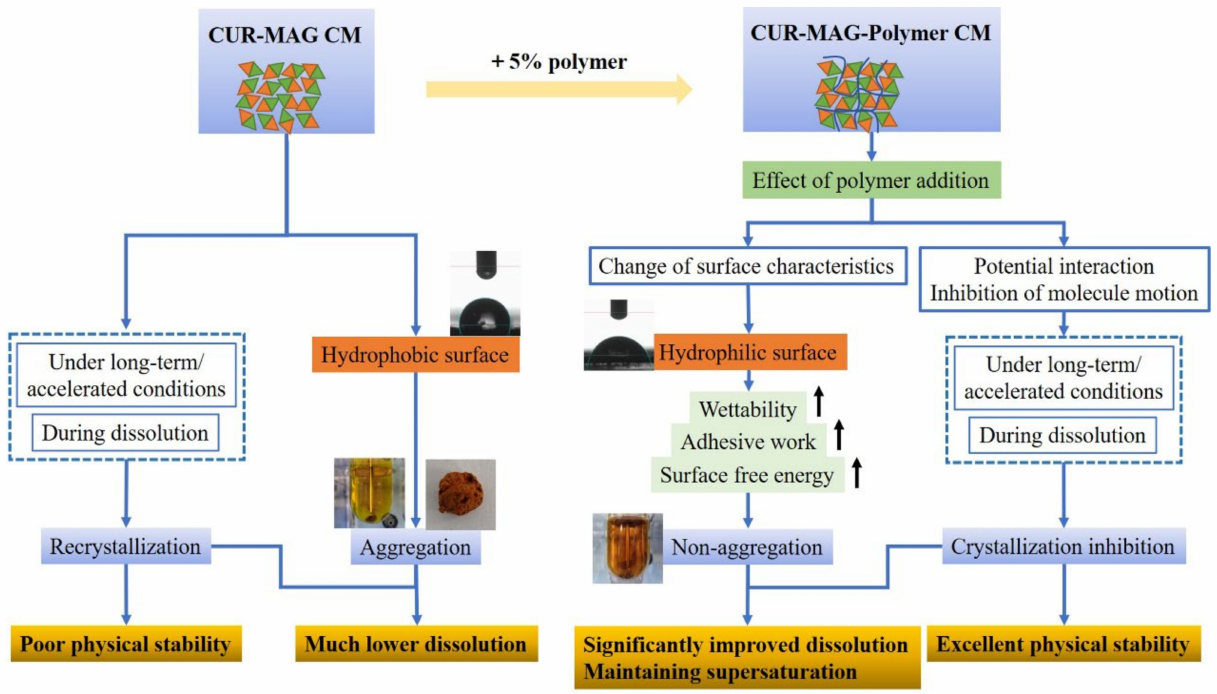
Figure 14. Summary of deaggregation and crystallization inhibition by polymer addition in optimizing the dissolution and physical stability of CUR-MAG